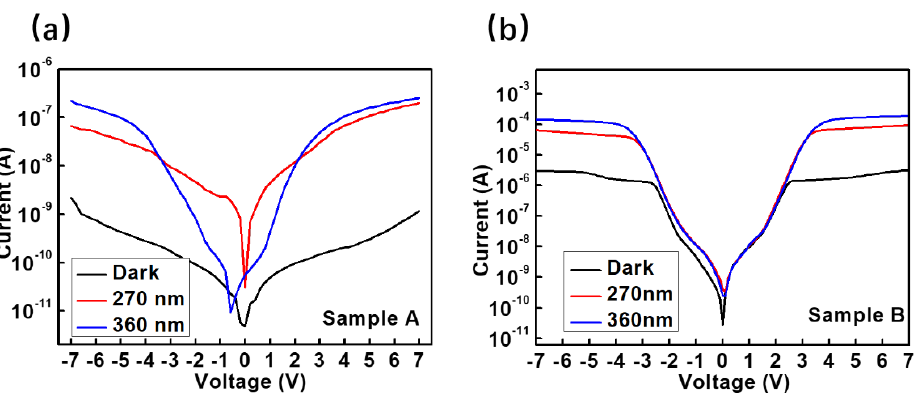
Figure 4. I − V characteristics of samples A ( a ) and B ( b ) in the dark and under 254 nm/365 nm UV illuminations.